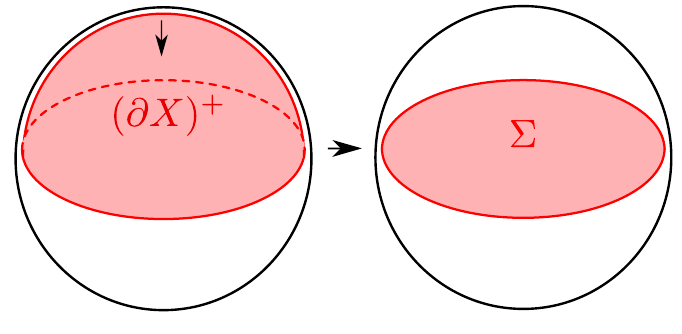
Figure 2 . Using conservation we can push the symplectic form from half of the Euclidean boundary to an arbitrary bulk slice (cid:6) anchored to the boundary at t E =